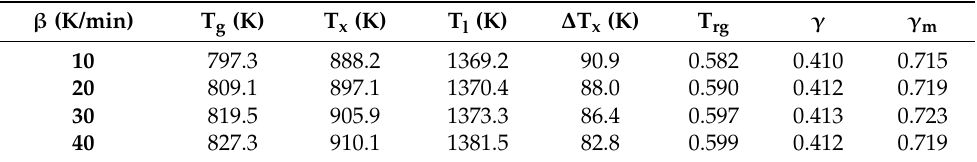
Table 2. The thermal properties and ∆ T x , T rg , γ , γ m of Al-Ni measured at 10, 20, 30 and 40 K/min heating rates. β (K/min)